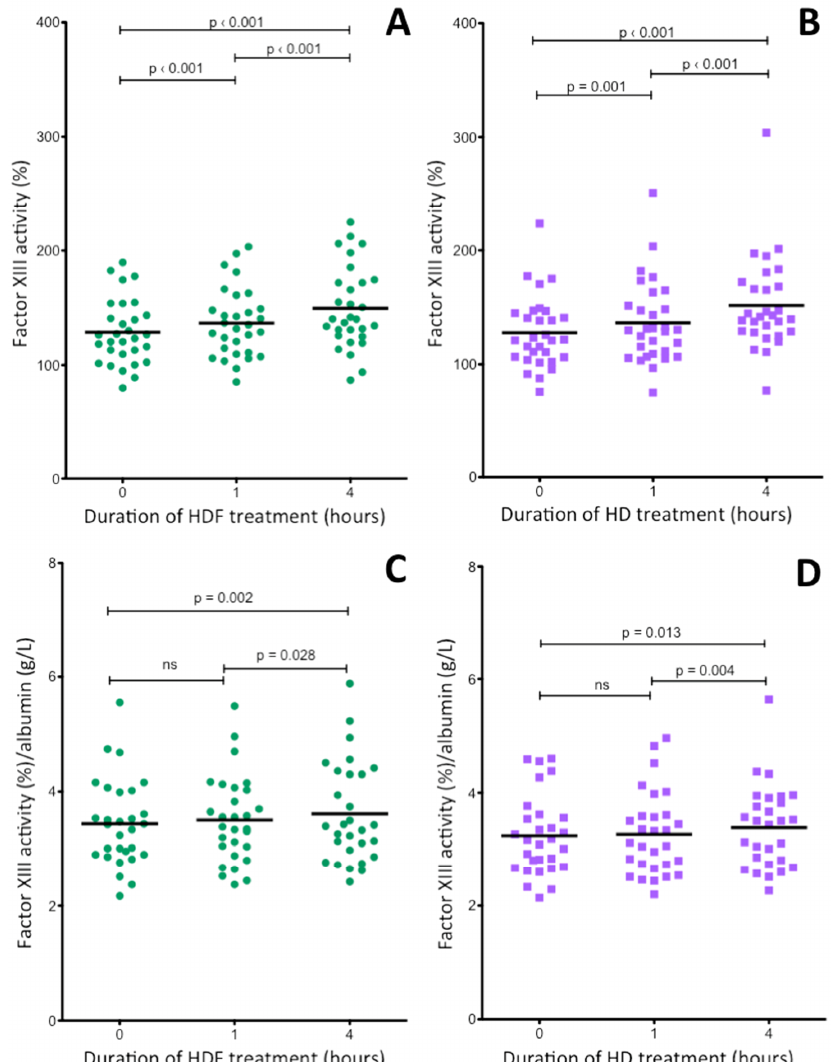
Figure 5. Changes of plasma FXIII activity in ESRD patients during a 4-h HDF ( A , C ) or HD ( B , D ) treatment. The upper two figures show FXIII activities not corrected for albumin ( A , B ), while FXIII activities corrected for albumin concentration are shown in the two lower figures ( C , D ). Horizontal lines represent mean FXIII activities. Significant differences between results obtained before and after treatments are indicated by the p values above thin horizontal lines.